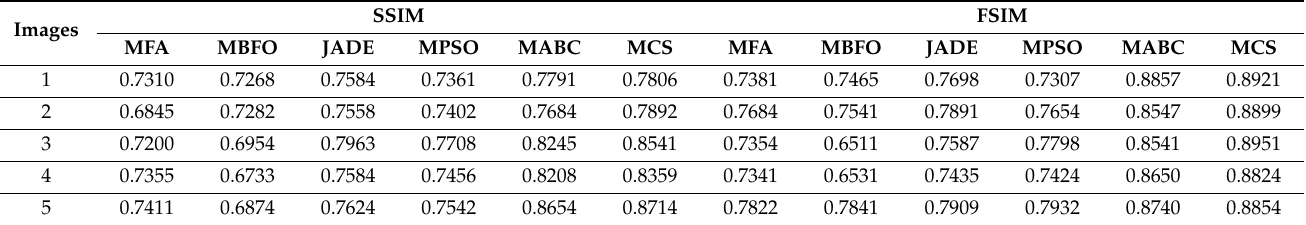
Table 4. Comparison of SSIM and FSIM computed by different algorithms using the EC-Otsu method.